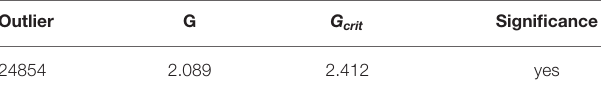
TABLE 12 | The results of Grubbs’ tests by-products and accumulated sales (product with shortage). Outlier